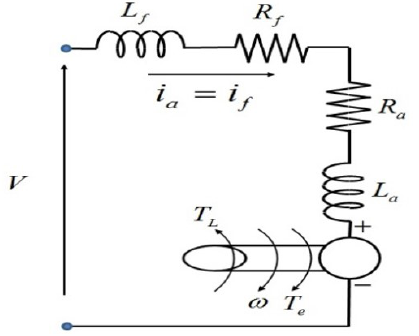
Figure 2. Electric diagram of a series DC